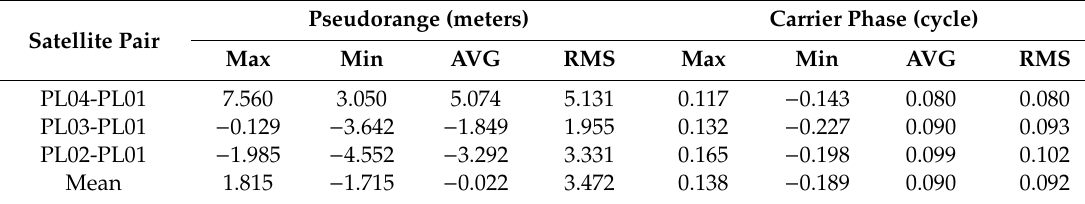
Table 3. Characteristics of pseudolite measurement error for short